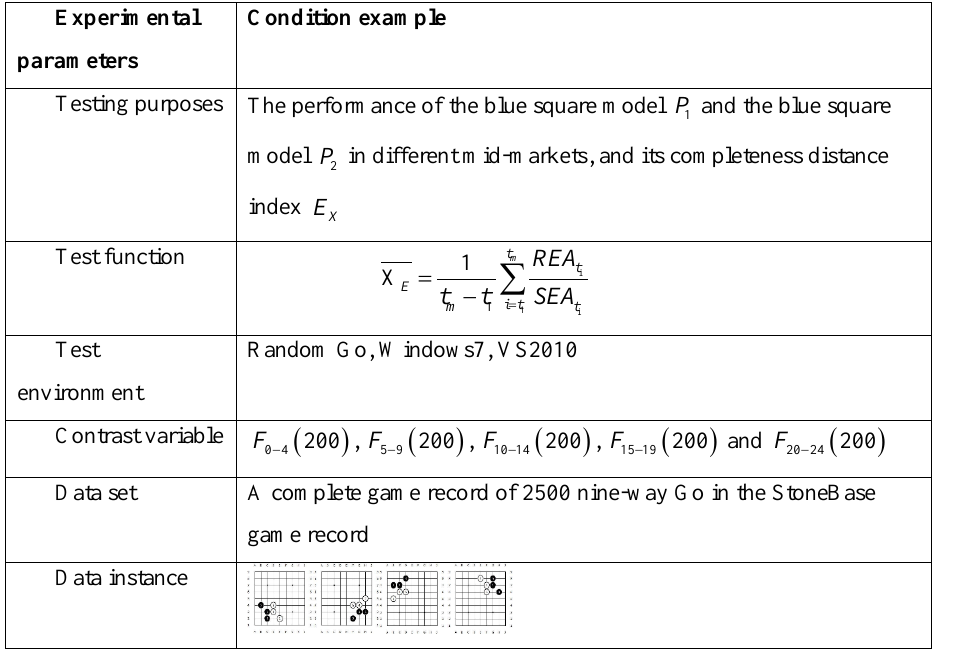
Table 1 Model P 1 and model P 2 completeness distance index E X experimental information